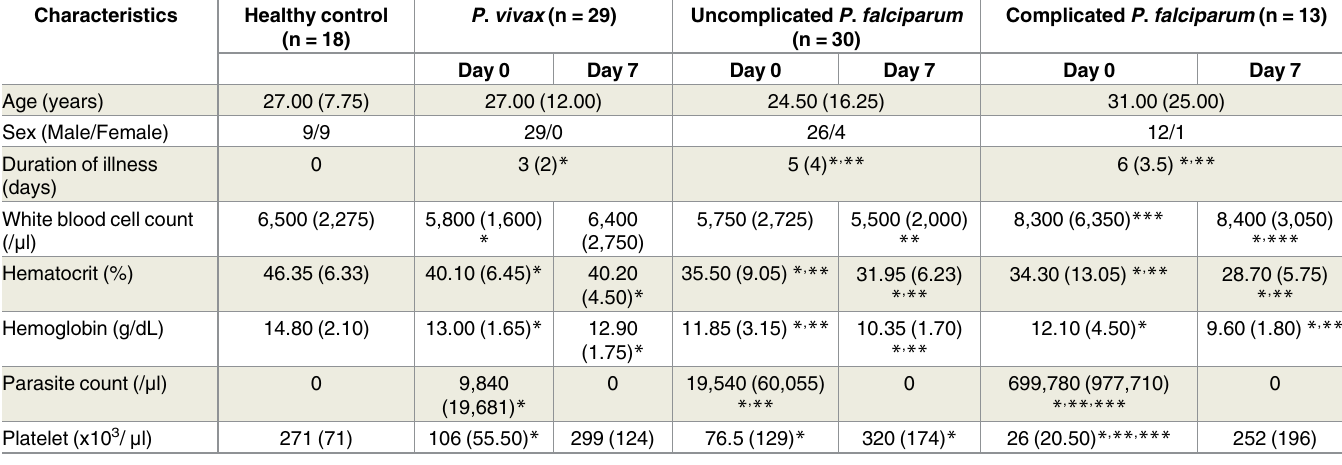
Table 1. Clinical data of the malaria patients and healthy controls.